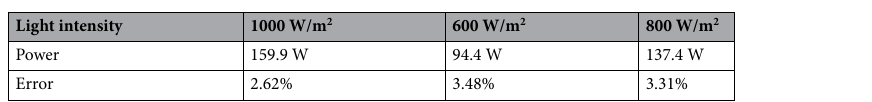
Table 4. Output power of two conductance increment methods under different light